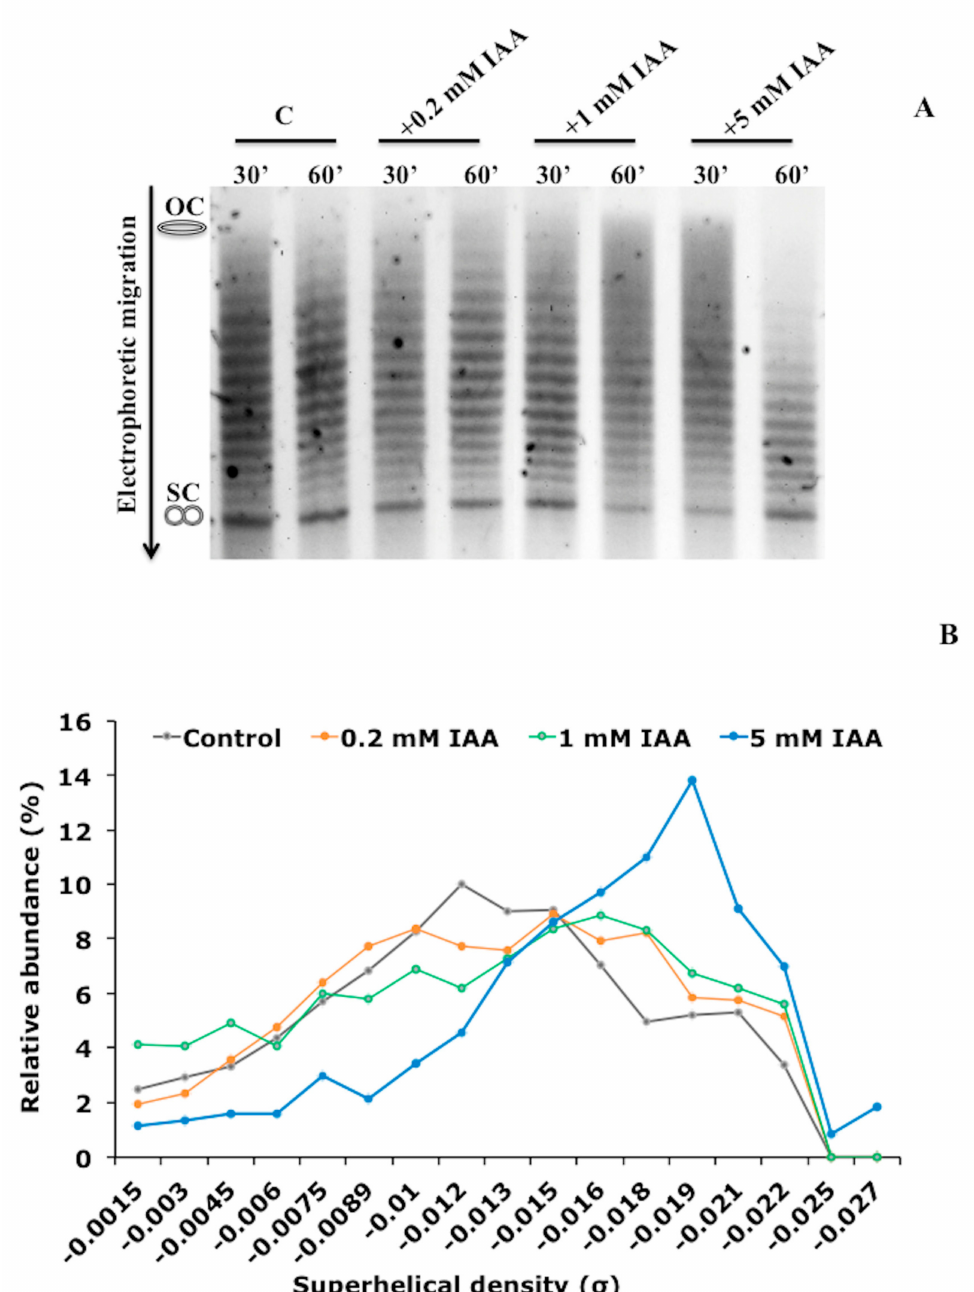
Figure 1. E ff ect of indole-3-acetic acid (IAA) on DNA topology in Ensifer meliloti cells. ( A ) Analysis of the relative topoisomers distribution for the plasmid pMB393. The pMB393 plasmid was purified from E. meliloti 1021 control cells and the ones treated for 30 and 60 min with IAA (0.2, 1, and 5 mM) and separated by electrophoresis in 0.7% agarose gels containing 10 µ g mL − 1 chloroquine. ( B ) Topoisomers’ distribution calculated as a percentage of topoisomers with specific superhelical density versus total DNA in untreated control cells, and cells treated for 60 min with 0.2, 1, and 5 mM IAA. The topological state of each topoisomer is expressed as the specific superelical density ( σ ). OC, open-circular DNA; SC, supercoiled DNA. The electrophoretic mobility reported in Figure 1A is a representative image of three biological